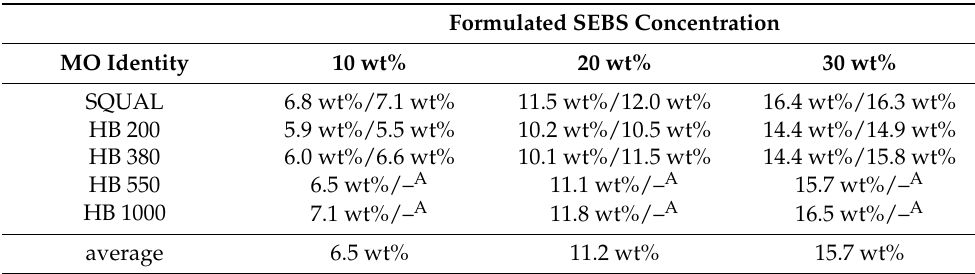
Table 1. Final SEBS concentrations for each formulated and subsequently preswollen gel batch. Within each box, gels with 0.5 wt% OA and 1.0 wt% AOT appear on the left and right, respectively.